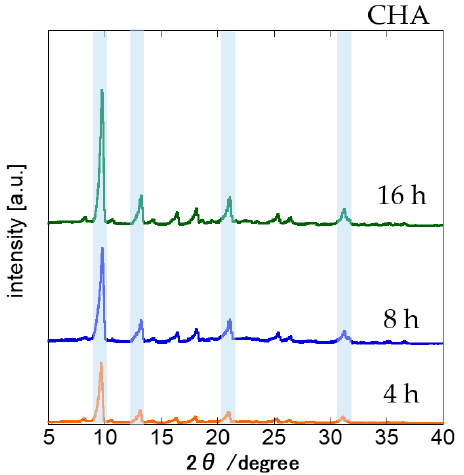
Figure 1. XRD measurements for the membranes crystallized for varying synthesis times (1 SiO 2 :0.8 TMAdaOH:0.8 HF:4.6 H 2 O, 0.01 wt% CHA seeds, at 423 K).